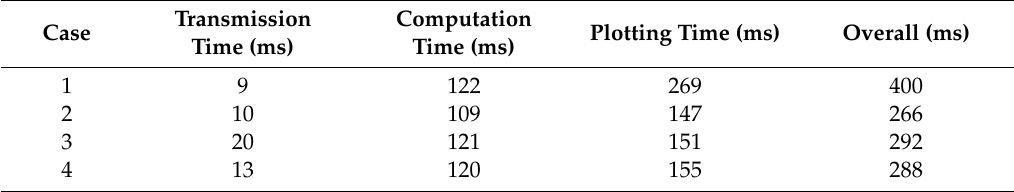
Table 2. Computing time for transmission, computation, and